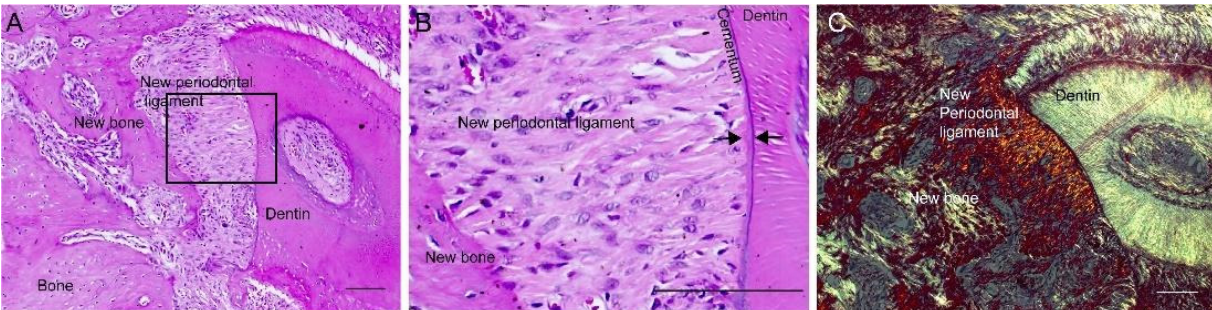
Figure 5. Deposition of cementum-like matrix on dentin and organization of new periodontal ligament on defects with- out treatment (T0), as thin acellular cementum layer ( A – C ). Higher magnification of the indicated area of ( A ), with perpendicularly inserted fiber bundles on the cementum-like matrix (between arrows) ( B ). Periodontal tissue fibers anchored between new bone and cementum-like matrix newly deposited on dentin ( A – C ). Polarized PSR imaging of the same specimen ( C ). H&E stain ( A , B ); and PSR stain ( C ); scale bars 100 μ m.